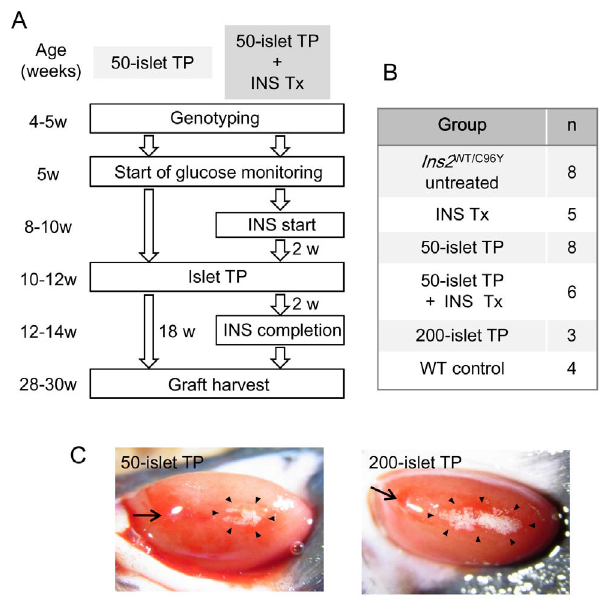
Figure 1. Groups and protocol. (A) Schematic drawing of the experiment for evaluating the effect of insulin treatment on islet transplantation. Heterozygous male Akita mice ( Ins2 WT/C96Y ) were used as recipients. Small insulin implants were used for insulin treatment. Glucose monitoring was started from 5 weeks of age. In mice transplanted with 50 islets without insulin treatment (50-islet TP), islet transplantation was performed at 10–12 weeks of age. In mice transplanted with 50 islets in combination with insulin treatment (50- islet TP + INS Tx), insulin implants were inserted when the mice reached 8–10 weeks of age. After 2 weeks, islet transplantation was performed (10–12 weeks of age). Implants were removed 2 weeks after islet transplantation (12–14 weeks of age). Glucose monitoring was continued until 18 weeks after islet transplantation (28–30 weeks of age). (B) Numbers of mice in each group. (C) Images of 50 (left) or 200 (right) islets transplanted under the left kidney capsule of Akita mice. Images were obtained immediately after transplantation. Arrows indicate catheter insertion sites, and arrowheads indicate the outer boundary of the transplanted